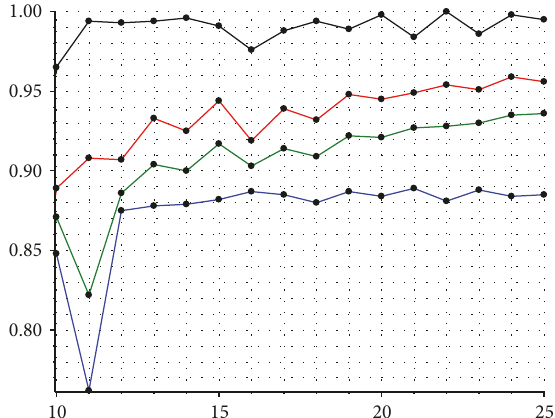
Figure 6: Graph of Table 2 (blue: 𝛼(𝑘,𝑆(𝑛)) , red: 𝛼(𝑘, 𝐵(𝑛)) , green: 𝛼(𝑘, 𝐻(𝑛)) , black: 𝛽(𝑘,𝐵(𝑛),𝑆(𝑛)) ). In our experimental range, 𝛽(𝑘,𝐵(𝑛),𝑆(𝑛)) is oscillating as an upper bound and 𝛼(𝑘,𝐻(𝑛)) is increasing with decreasing fluctuations thanks to domination of 𝛼(𝑘,𝐵(𝑛)) , while 𝛼(𝑘,𝑆(𝑛)) confirms Pinn’s conjecture.